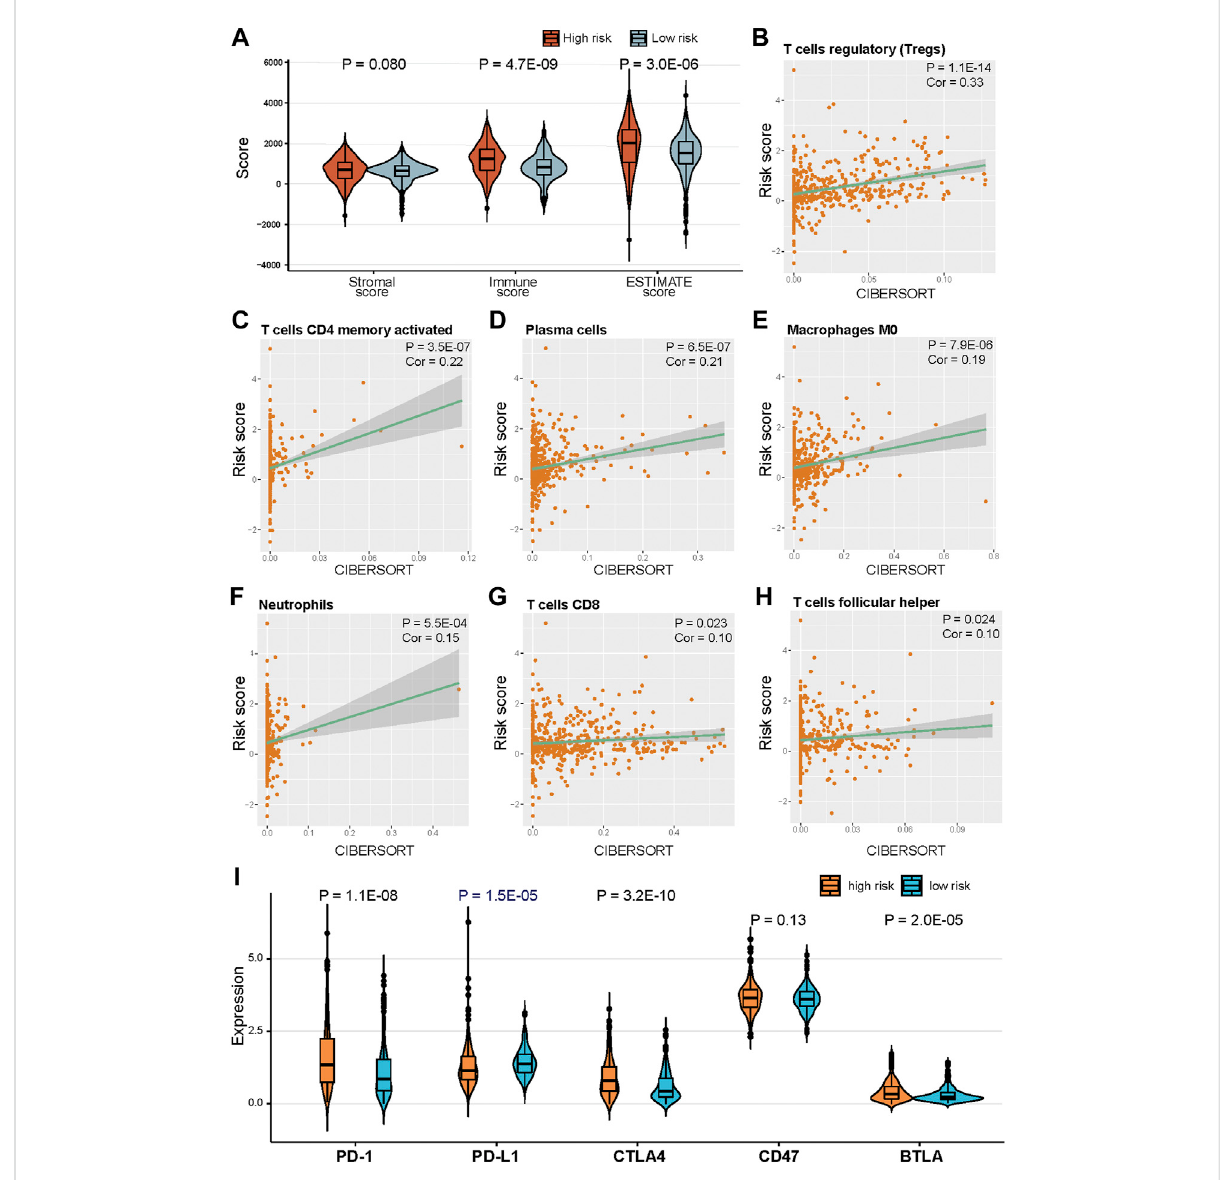
FIGURE 7 Correlation of risk score and immune cells in fi ltration. (A) Distribution of ESTIMATE score in high risk and low risk groups. (B) – (H) Positive correlation between risk score and immune cells. (H) Distribution of ESTIMATE score in high risk and low risk groups. (I) Expression of fi ve immune checkpoints in high risk and low risk